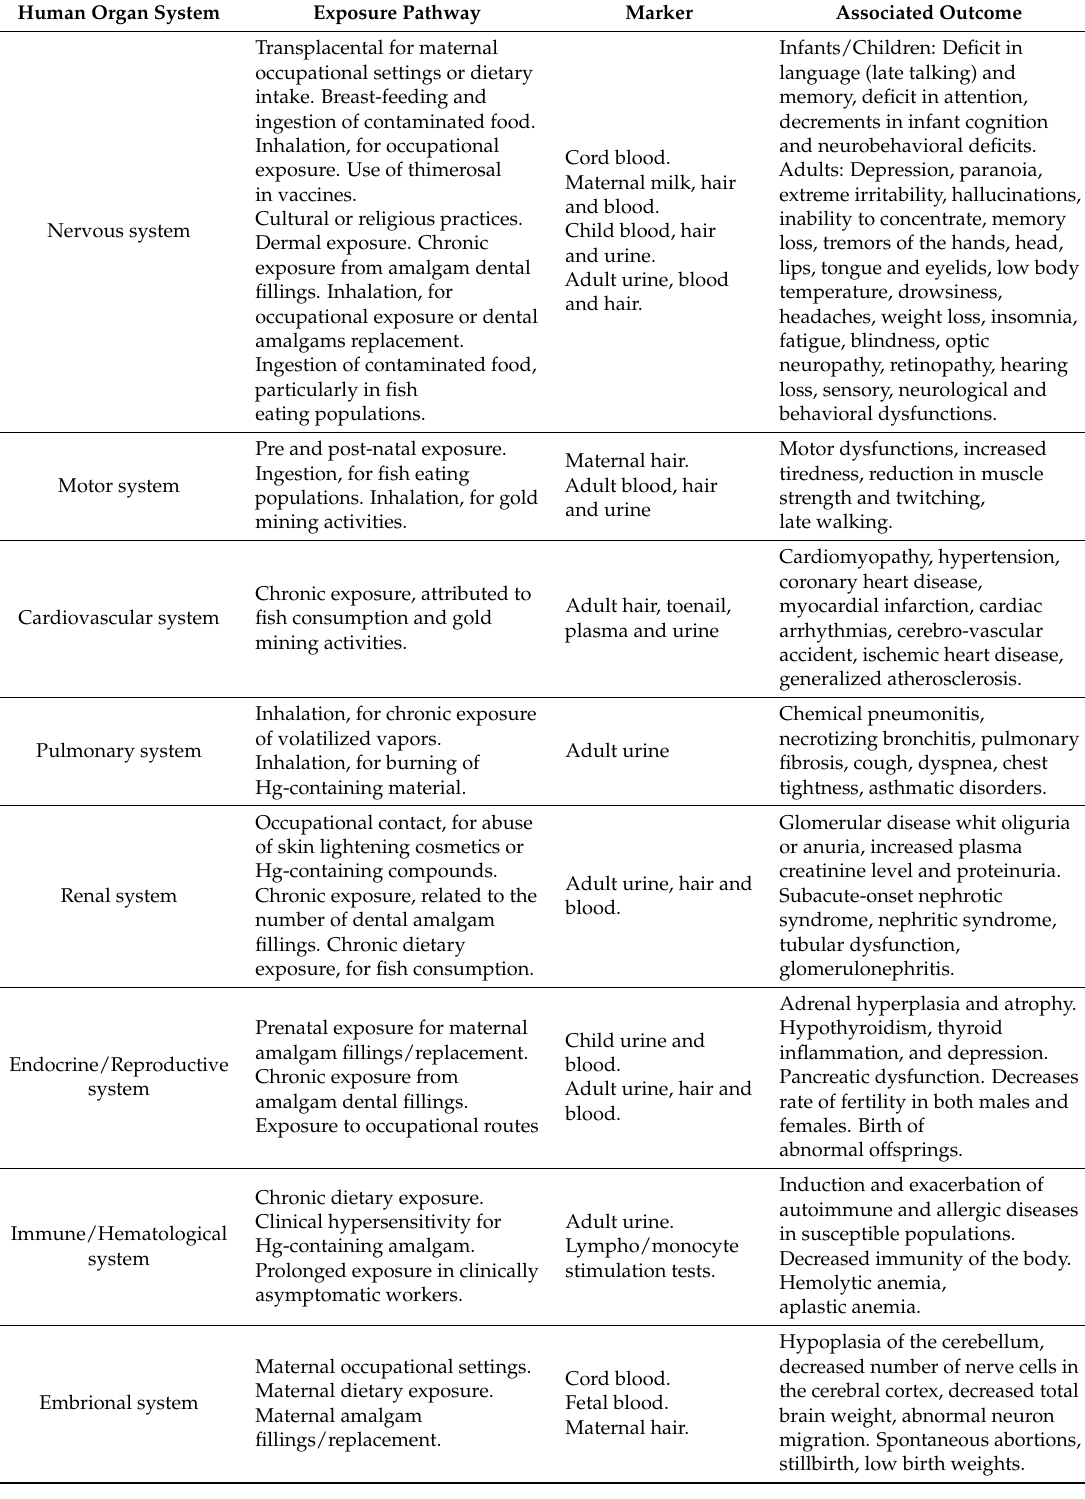
Table 1. Systemic toxicological effects and symptoms of mercury